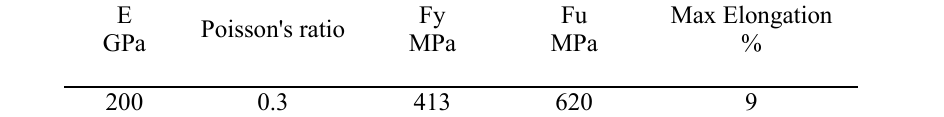
Characteristics of the ASTM-A615 Grade 60 steel bar used in this study.